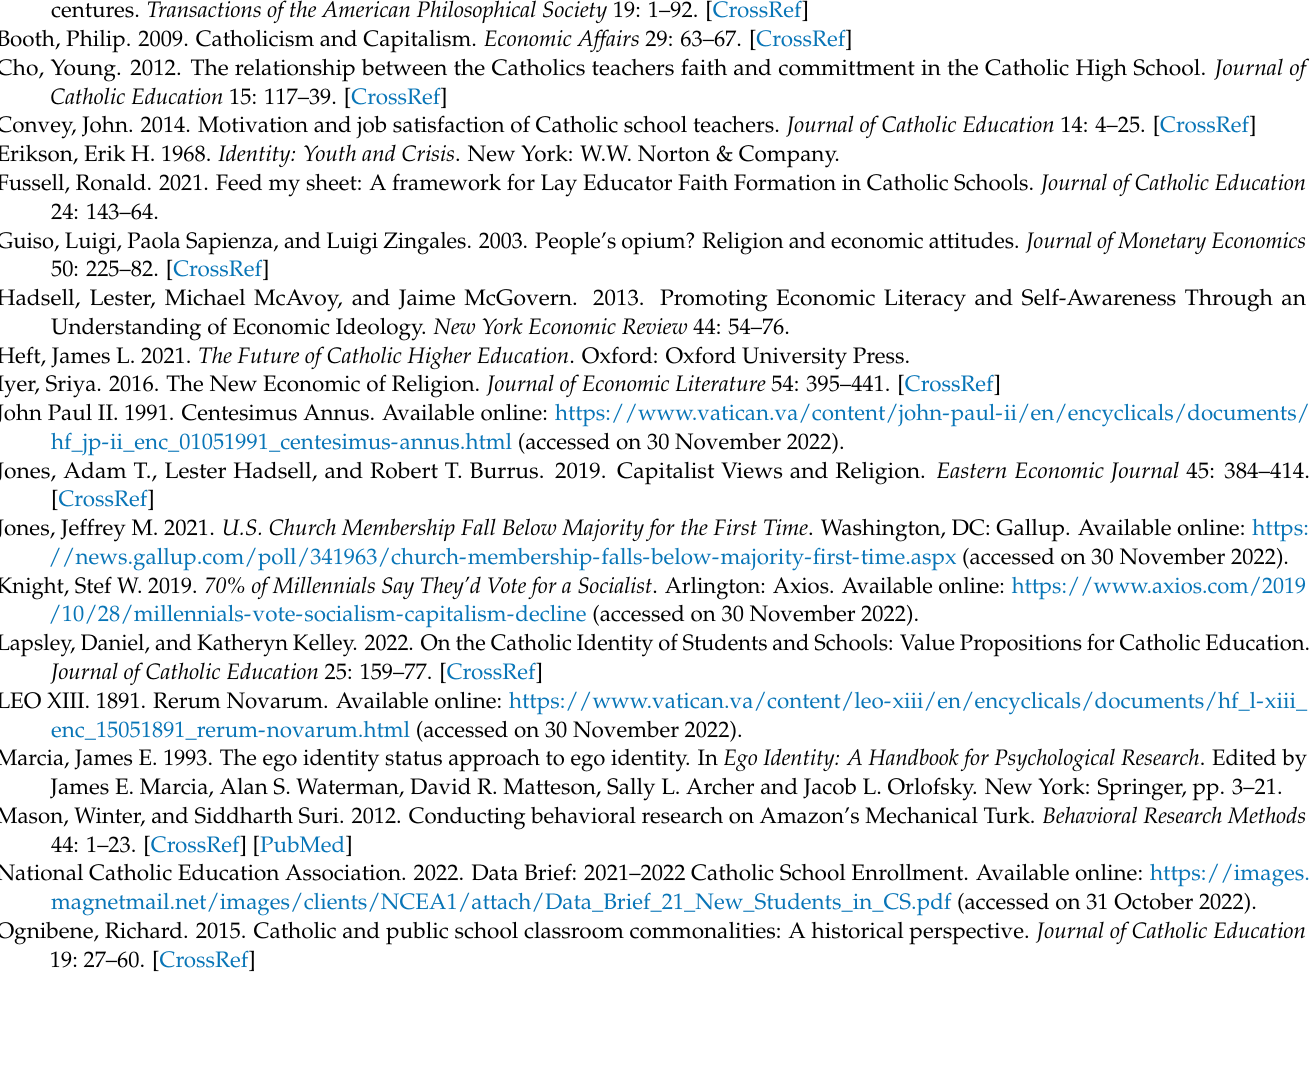
table, including a full set of the control variables. Jones et al. (2019) included religious school attendance in their analysis but did not limit responses to those who only attended one level of schooling; thus, respondents attending multiple levels of schooling with heterogeneous effects confounded the